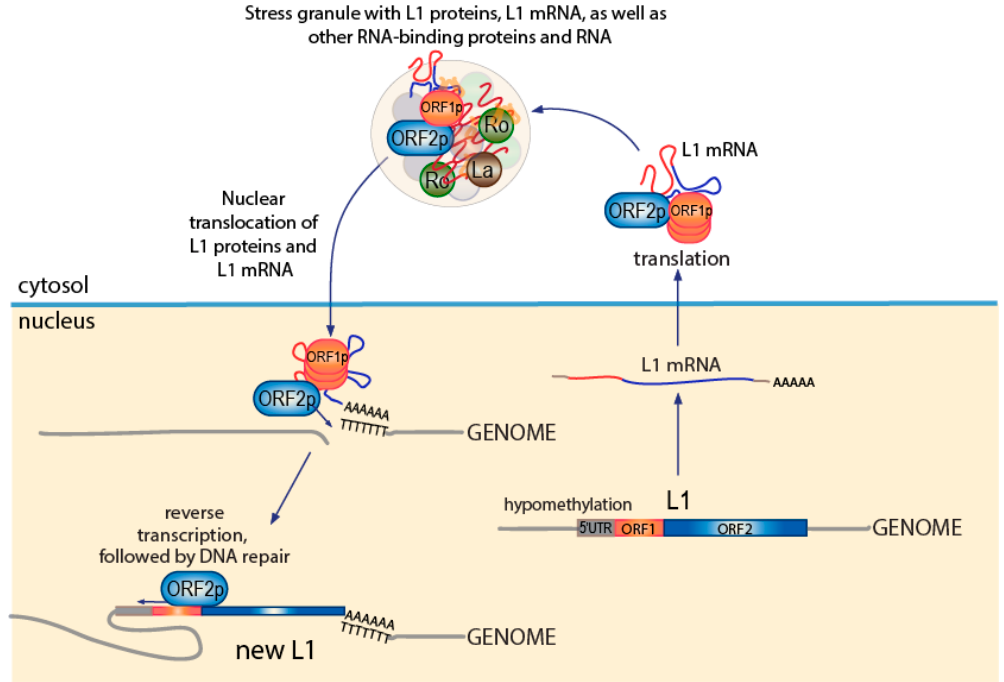
Figure 2. The L1 retrotransposition process. A similar figure is in (40).